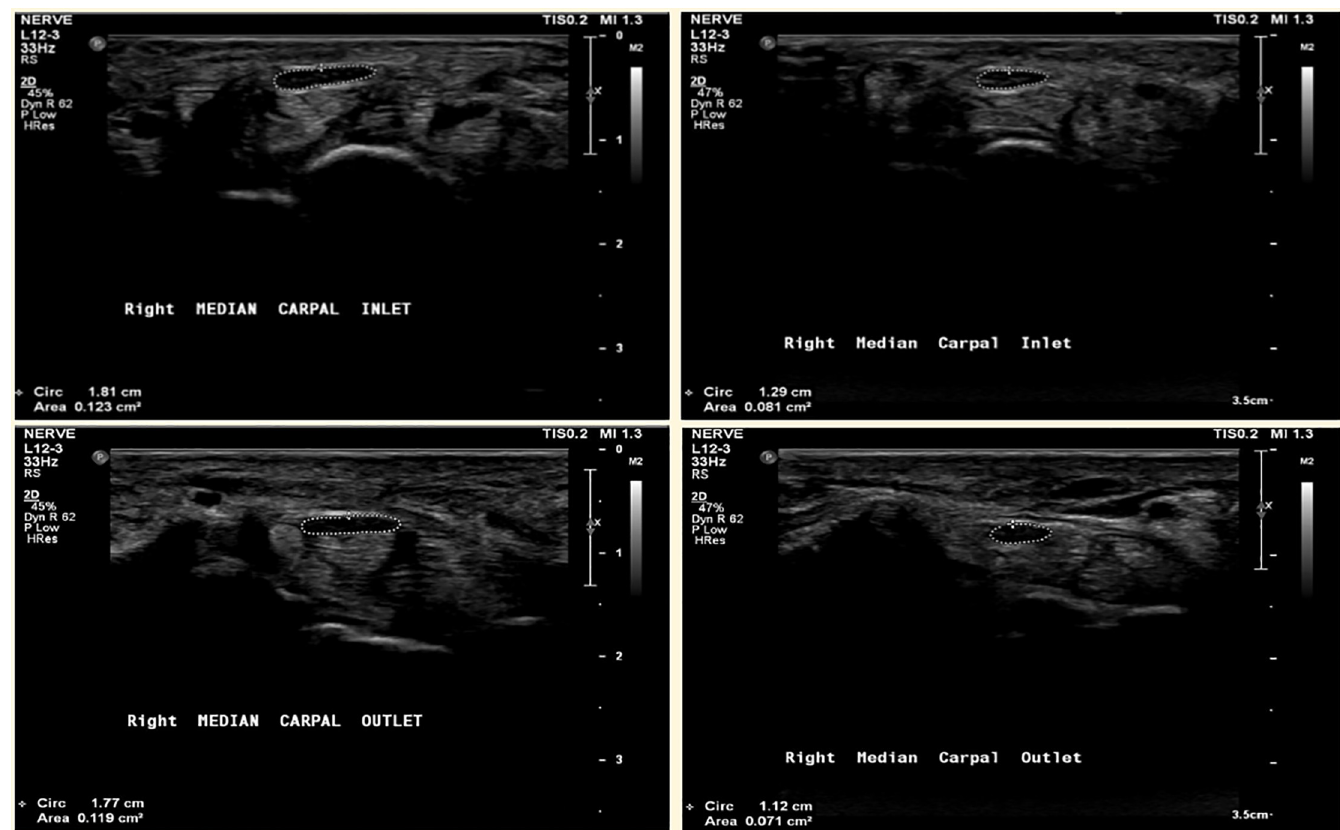
Fig 1. Ultrasound image of the median nerve cross-sectional area (CSA) at the carpal tunnel level. Median CSA of patient (A, B) and healthy control (C,